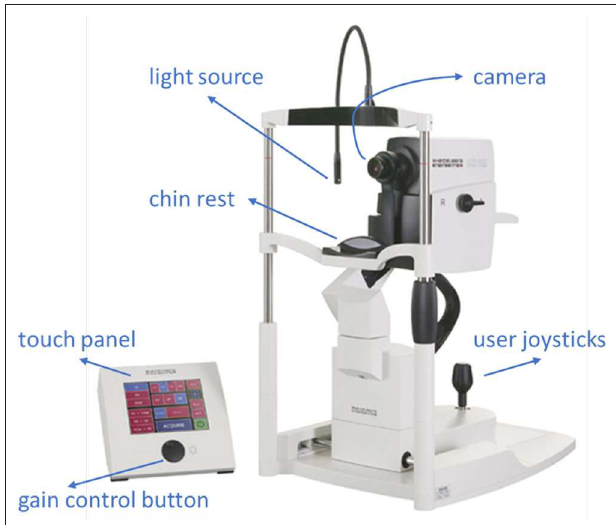
FIGURE 1 | Fundus camera (SPECTRALIS OCT) (Courtesy of Heidelberg Engineering Inc.)